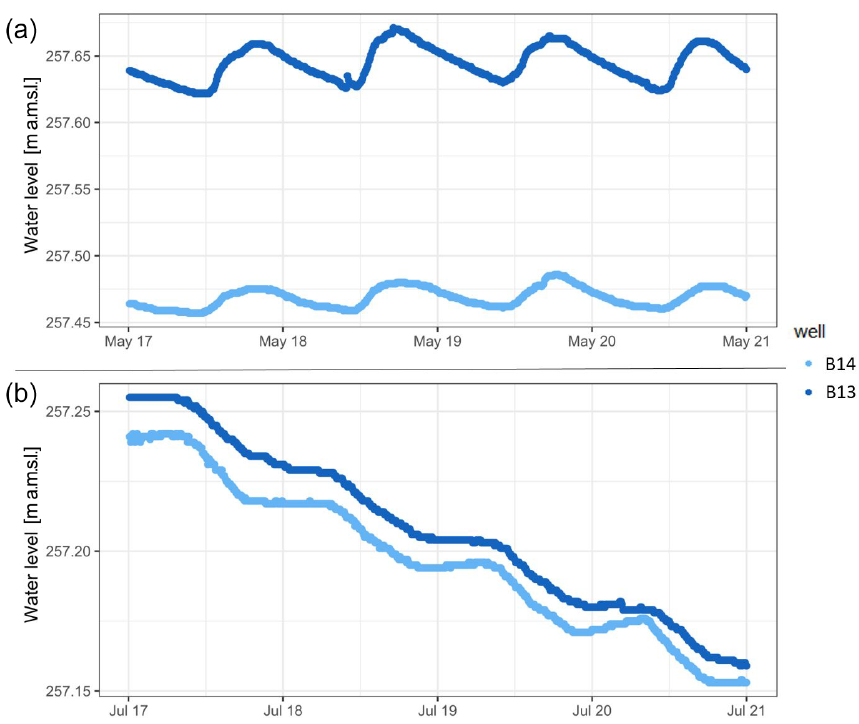
Figure 9. Example time series showing diurnal variations in groundwater levels for two wells during the late snowmelt period in May 2020 (a) and the summer (July 2020) when diurnal variations are caused by evapotranspiration (b)